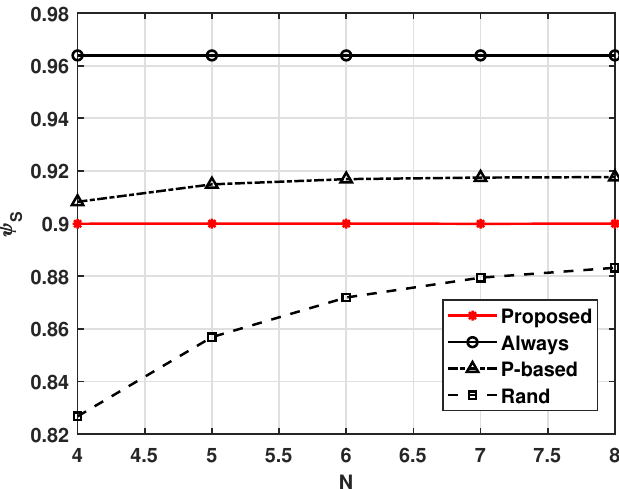
Figure 8. Average energy consumption ψ S versus N .